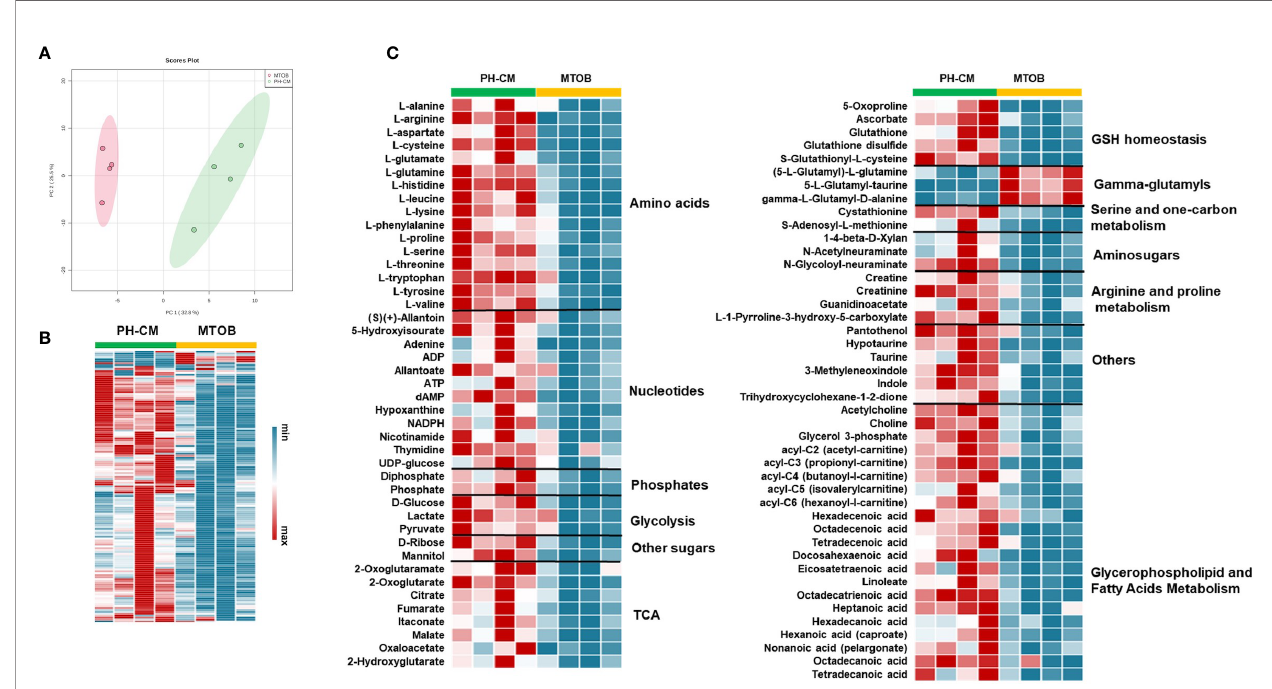
FIGURE 7 | Inhibiting CtBP1 reduced metabolites production in response to PH-CM. (A) Principle Component Analysis (PCA) showing clear separation of metabolites produced from BMDMs co-cultured with PH-Fibs with or without MTOB, CtBP1 inhibitor, treatment. (B) Heat-map showing in general the concentration of metabolites produced from BMDMs co-cultured with PH-Fibs in the presence of MTOB were decreased compared to in the absence of MTOB. Each column represents an individual sample. (C) Heat-map showing metabolites that are signi fi cantly changed in BMDMs with MTOB treatment ( p ≤ 0.05).